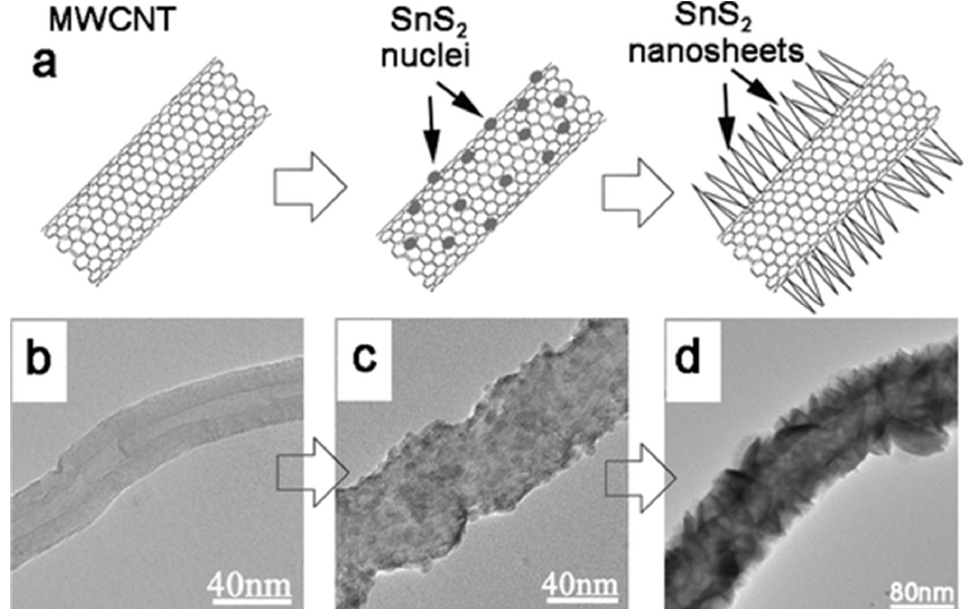
Figure 2. Schematic illustration and TEM images for the growth process of the SnS 2 NS@MWCNTs coaxial nanocables: ( a ) schematic illustration; TEM image of the product sonicated at different times ( b ) 0 h (pure MWCNT); ( c ) 20 min; ( d ) 6 h. Reproduced with permission of ref. [77]. Copyright 2011. American Chemical Society.